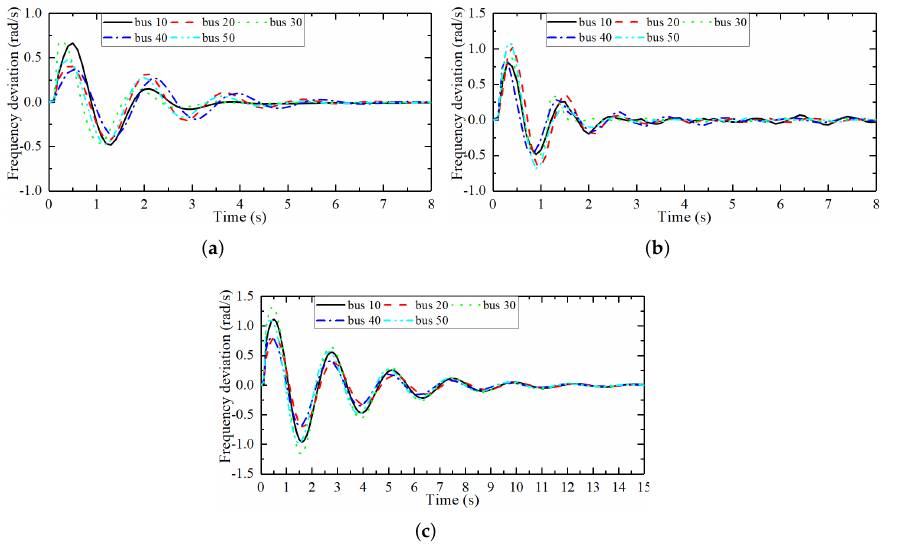
Figure 13. Frequency deviation curve of the IEEE 57 bus testing system under three different methods, η ji = 0.05. ( a ) Based on convex neural networks. ( b ) Based on RBF neural networks. ( c ) Based on RNN neural networks.